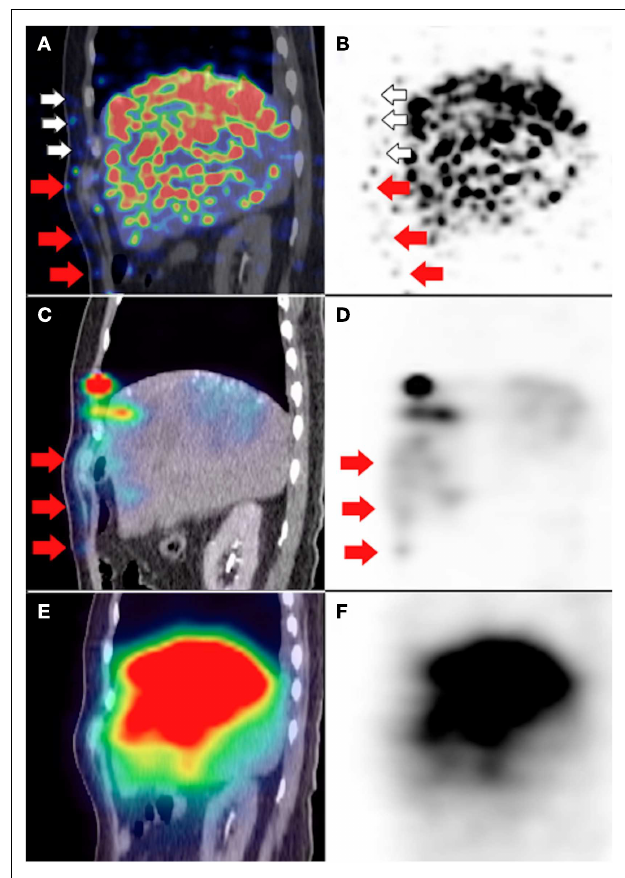
FIGURE 7 | (A,B) 90 Y PET/CT depicts in high resolution, non-target activity in a non-random distribution conforming to the anatomy of the right lower anterior chest wall (white and red arrows). (C,D) Pre-RE 99m Tc MAA SPECT/CT shows similar non-target activity along the right lower anterior chest wall (red arrows).The non-target chest wall activity on 90 Y PET depicted by white arrows was not seen on 99m Tc MAA SPECT/CT due to altered arterial flow and biodistribution after prophylactic bland embolization of at-risk chest wall branches. (E,F) 90 Y bremsstrahlung SPECT/CT